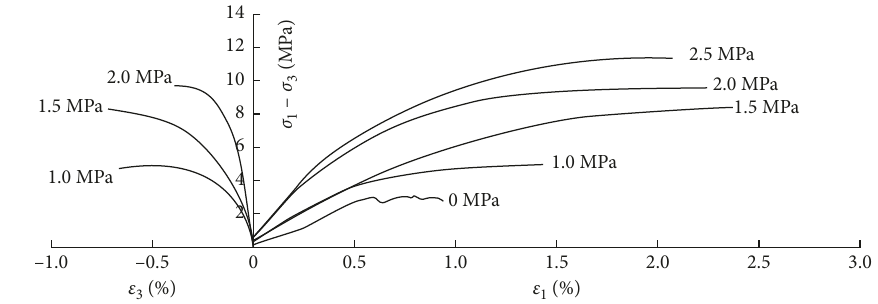
Figure 2: Complete stress-strain curve under different confining pressures